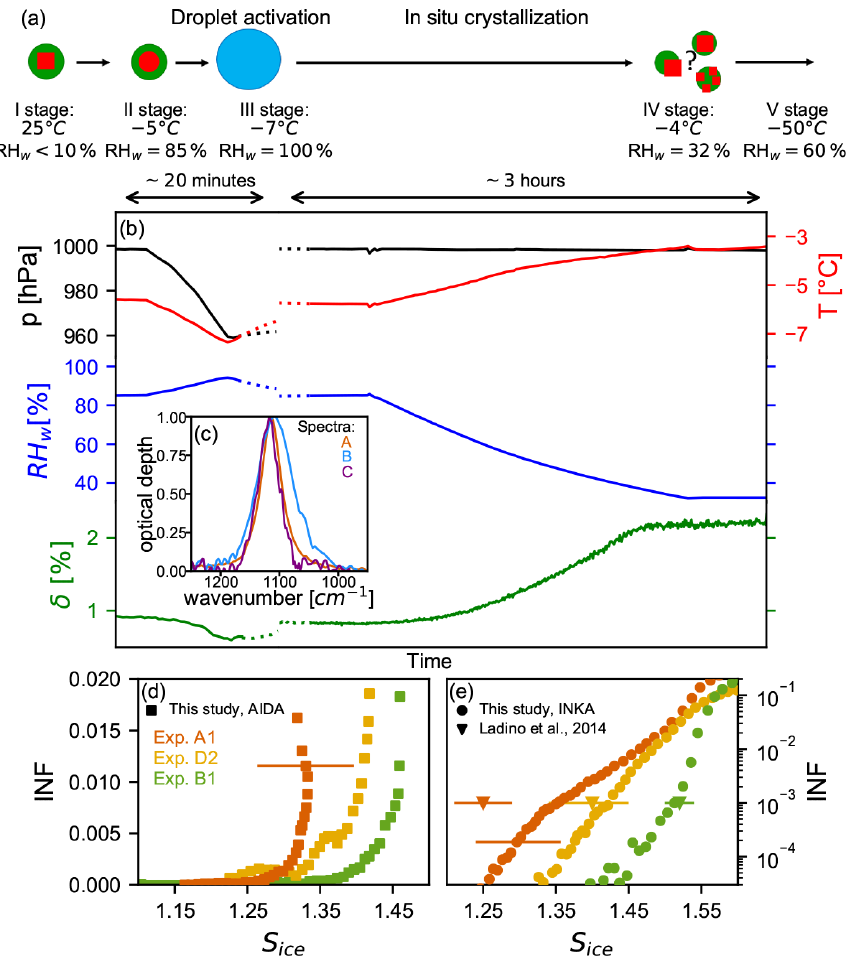
Figure 7. Liquid-cloud-processing, recrystallization, and ice nucleation results (experiment type D). (a) Schematic of the phase state and possible morphology of the particles after the in situ crystallization process. (b) Time series of pressure (black line), temperature (red line), relative humidity with respect to water (blue line), and backscattering linear depolarization ratio (green line) during the in situ crystallization for experiment D2. The left part of the plot shows the short expansion run started at − 5 ◦ C and RH w = 85% to activate the seed aerosol particles to homogeneously mixed, aqueous droplets. After refilling of the AIDA chamber to ambient pressure (not shown in the figure), the relative humidity was reduced to RH w = 32% to induce the AS efflorescence. (c) Normalized infrared spectra in the regime of the ν 3 (SO 2 − ) mode obtained after transfer of the particles into the AIDA chamber (spectrum B) and after the in situ crystallization (spectrum C) 4 in comparison with a reference spectrum of pure AS crystals (spectrum A). Panels (d) and (e) show the ice-nucleating fraction as function of S ice for the AIDA and INKA experiments with pure AS crystals (experiment A1, orange symbols), unprocessed AS crystals with thick SOM coating (experiment B1, green symbols), and in situ crystallized mixed AS/SOM particles (experiment D2, yellow symbols). Ice onset results from Ladino et al. (2014) are reported in panel (e) as triangles: pure AS in orange, mixed AS/SOM particles in yellow, and pure SOA particles in